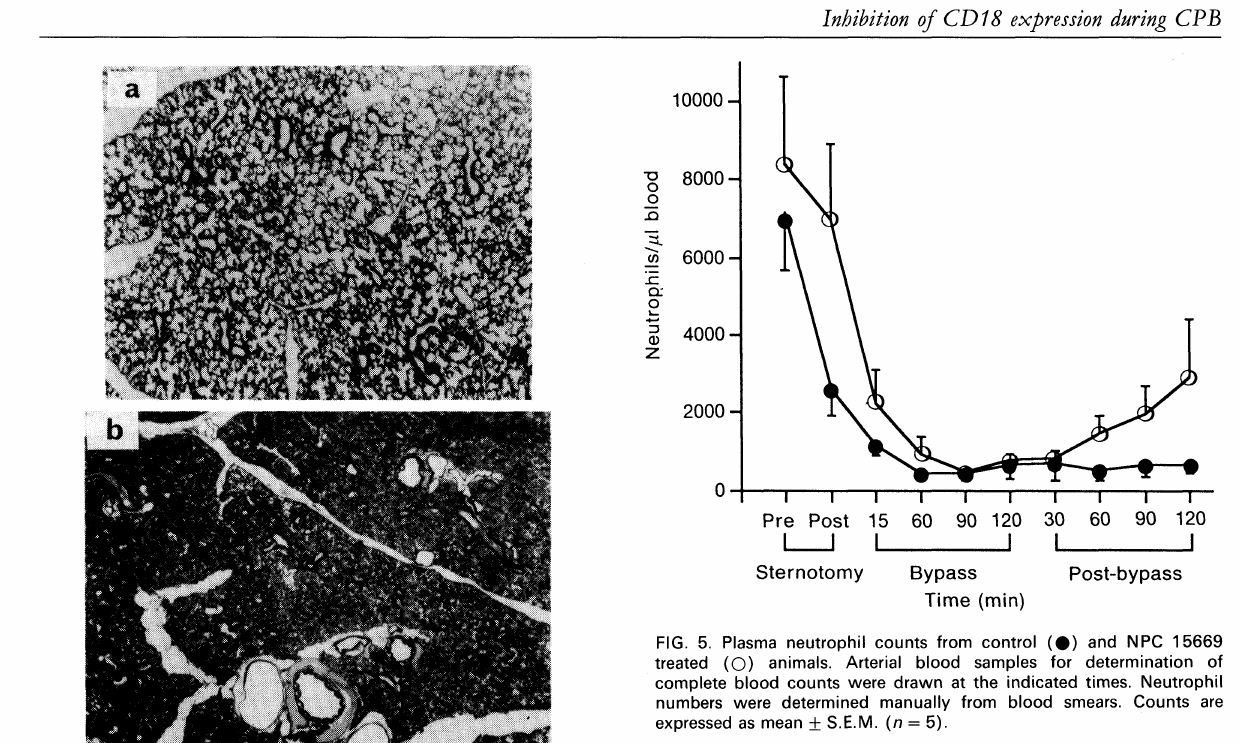
FIG. 4. (a) Photomicrograph of a representative lung section taken from a pig given NPC 15669 during CPB. The normal lung architecture is intact. The alveolar septae are thin and the alveolar spaces appear empty (haematoxylin and eosin, magnification 25); (b) Photomicrograph of a representative lung section taken from non-treated animal. The normal alveolar architecture is obscured. The alveolar spaces are filled with oedema fluid and individual alveolar spaces cannot be identified (haematoxylin and eosin, 25 ). intra-alveolar oedema and haemorrhage. In addi-